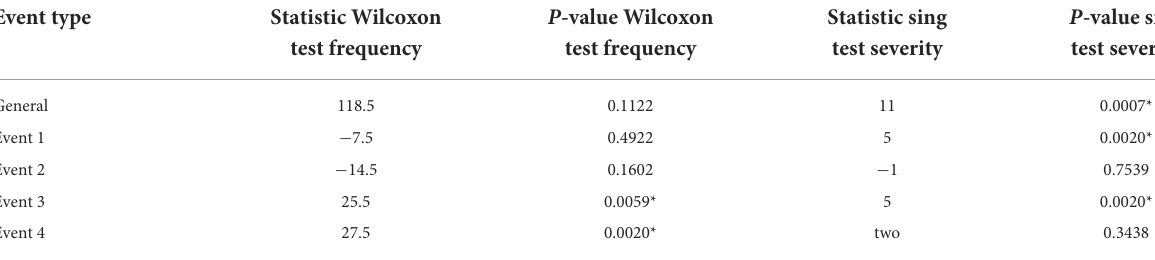
TABLE 5 Results of non-parametric tests for Monthly Frequency and Average Monthly Severity.